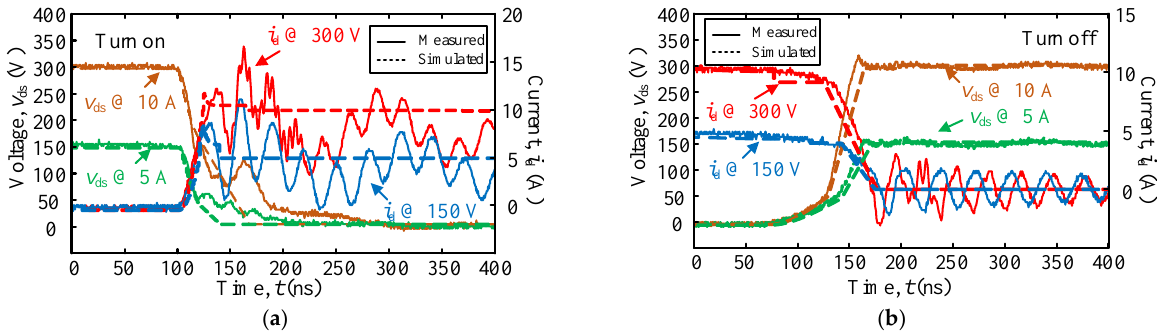
Figure 13. Switching waveforms of eGaN HEMT with SiC SBD ( a ) turn-on; ( b ) turn-off; @ 25 ℃,𝑅 G = 5 Ω .